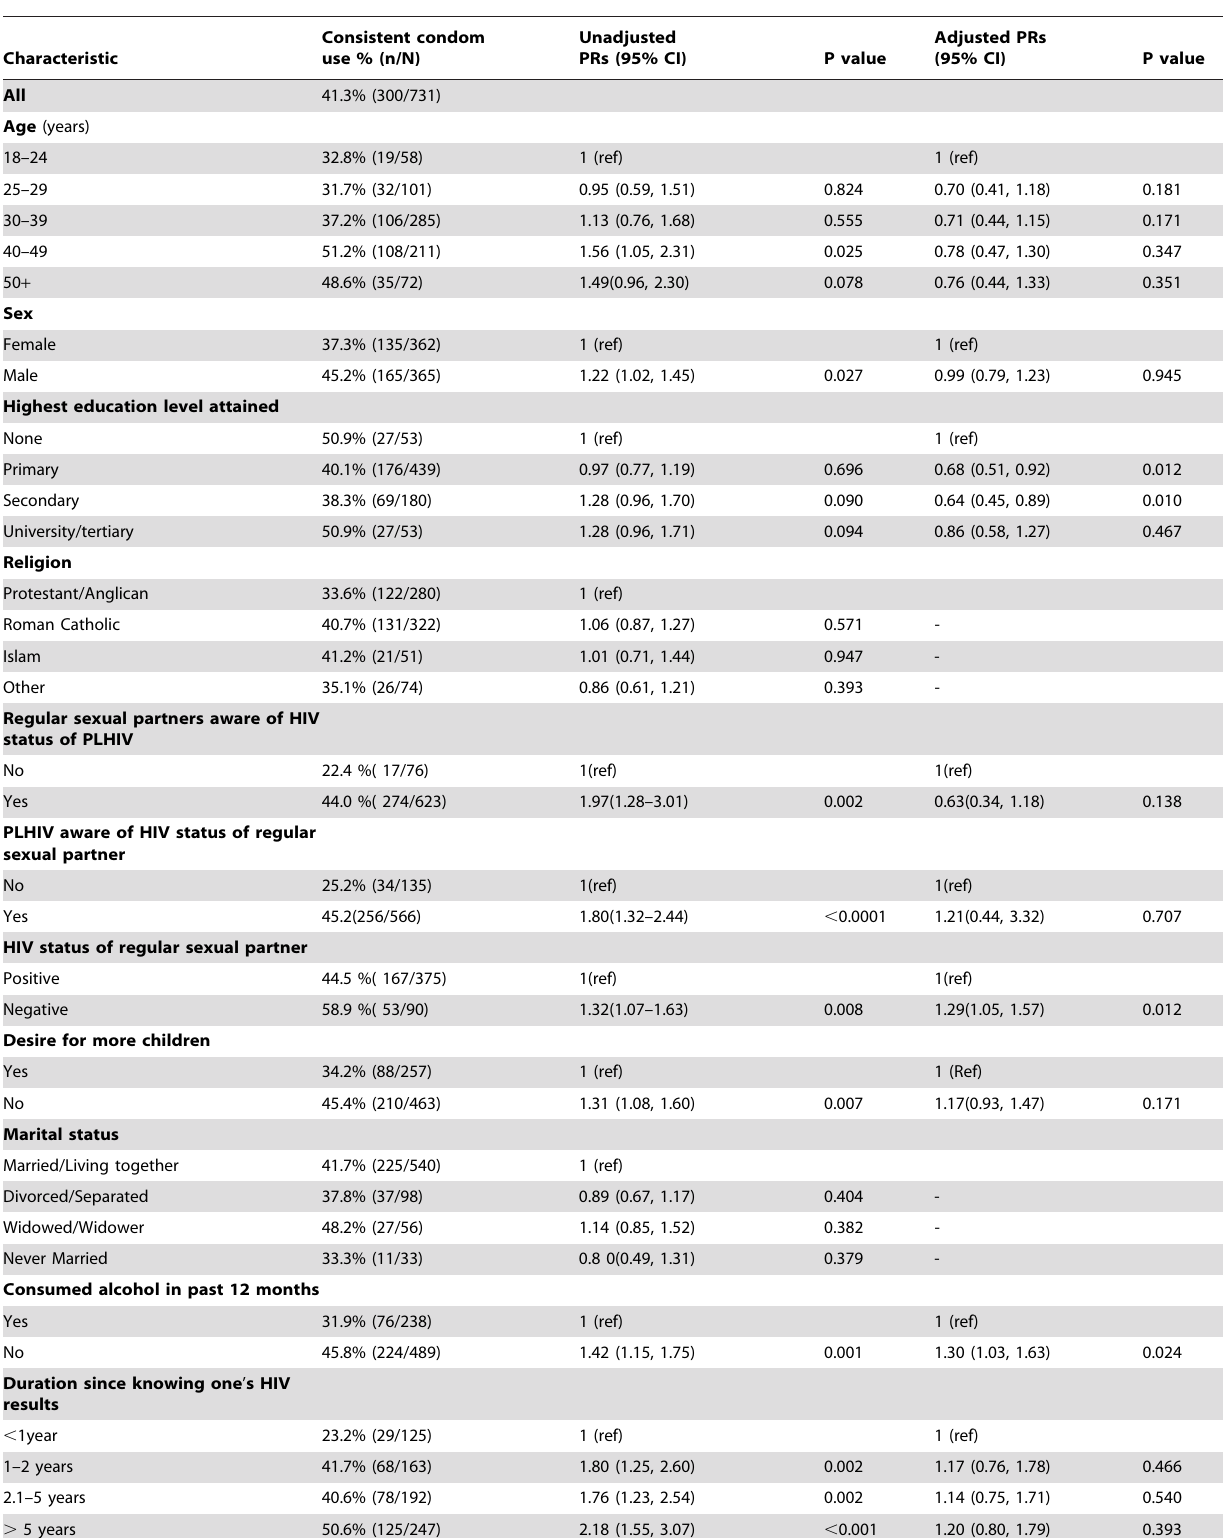
Table 3. Prevalence, unadjusted and adjusted prevalence ratios (PRs) of factors associated with consistent condom use in past 12 months among HIV positive clients attending CSO health facilities in